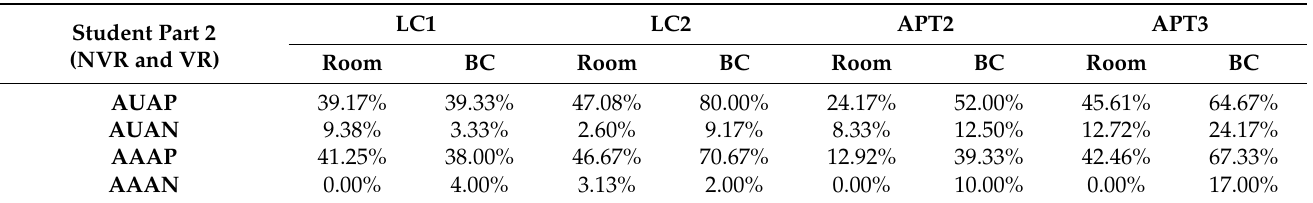
Table 11. Affordance presence is perceived by double media for each design component in LC and APT projects reviewed by students (Part 2).